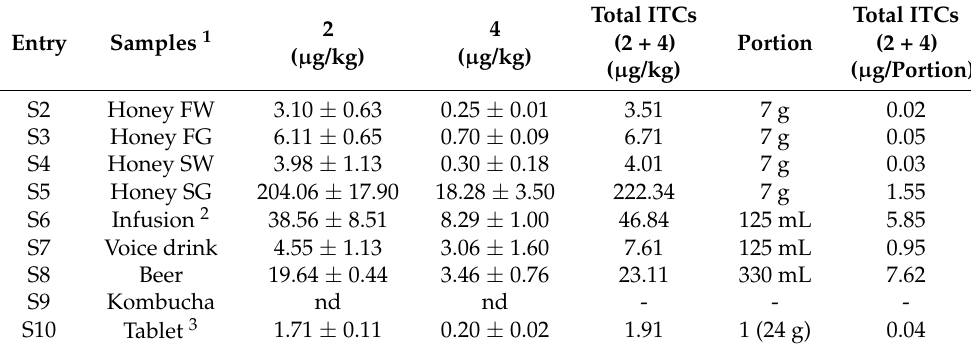
Table 2. Analysis of IPITC (2) and SBITC (4) released in food and drink preparations. Total ITCs (2 + 4) are reported as µ g/Kg of